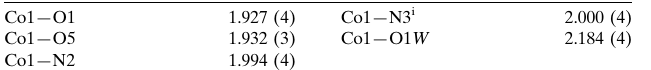
Selected bond lengths (A˚ ).